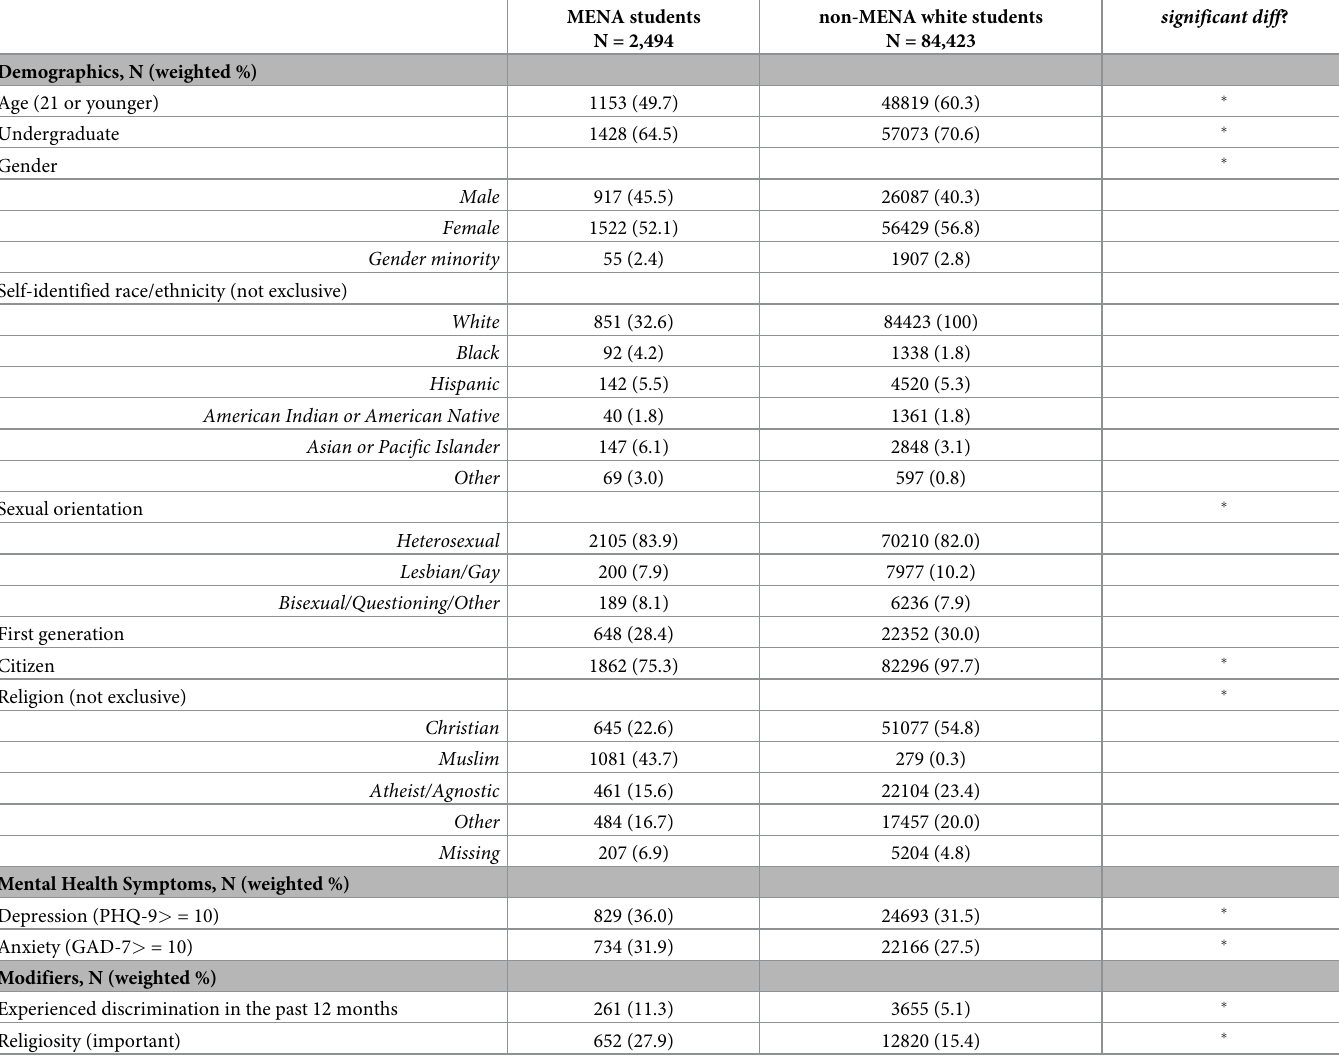
Table 1. Description of the Healthy Minds Study sample of Middle Eastern/Arab American (MENA) college students and non-MENA white college students.